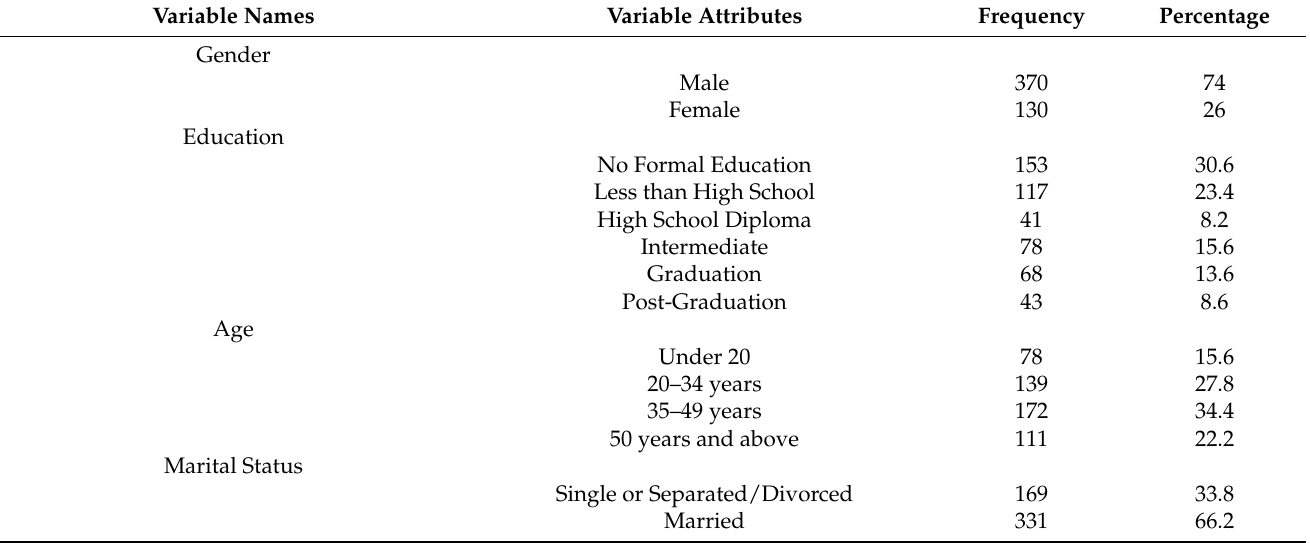
Table 1. Descriptive Statistics for Socio-Demographic Characteristics of Study Participants, Depalpur City, Pakistan, 2020 (N =